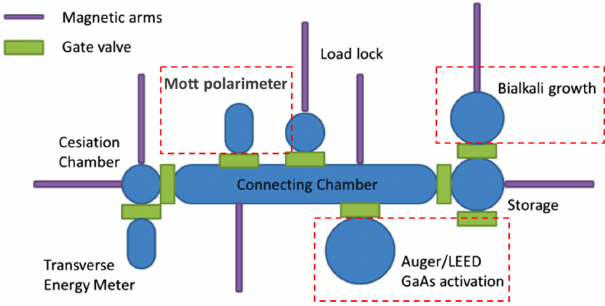
FIG. 2. Schematic of the cluster of vacuum chambers in the photocathode laboratory at Cornell University. Samples are transferred from one chamber to another in a vacuum level better than 1 × 10 − 10 Torr. The experimental chambers used in this set of experiments are indicated with dotted red